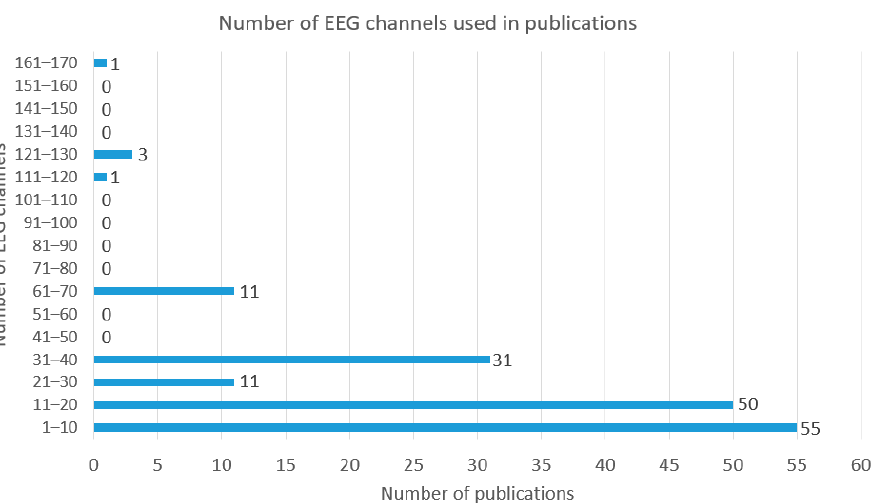
Figure 10. Number of EEG channels used in publications. In the majority of the publications, up to 40 EEG channels have been used.